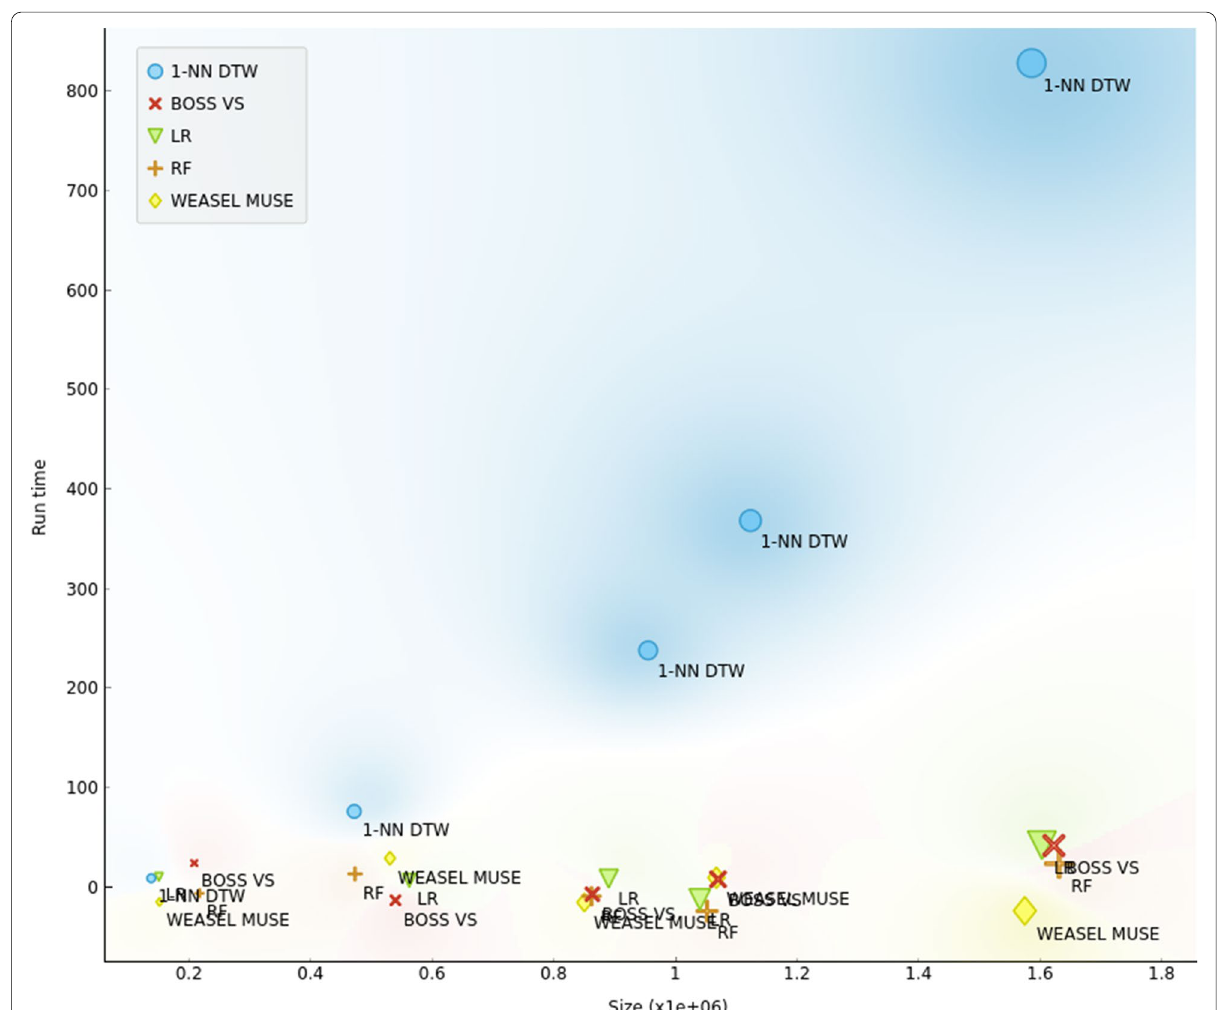
Fig. 11 Scalability comparison of five models. As the amount of data is increased, the 1‑NN‑DTW model shows the worst scalability. On the contrary, the other models offer good scalability. The BOSS VS model performs excellent scalability yet keeping the best